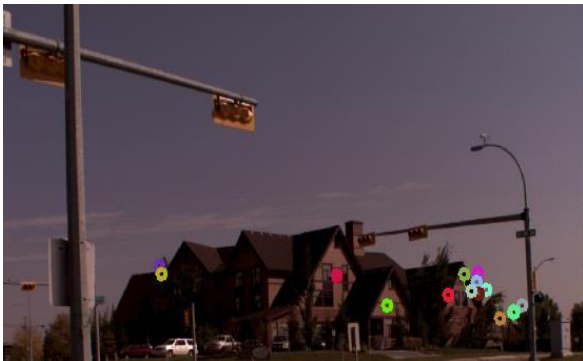
Figure 3. Result of registration the two